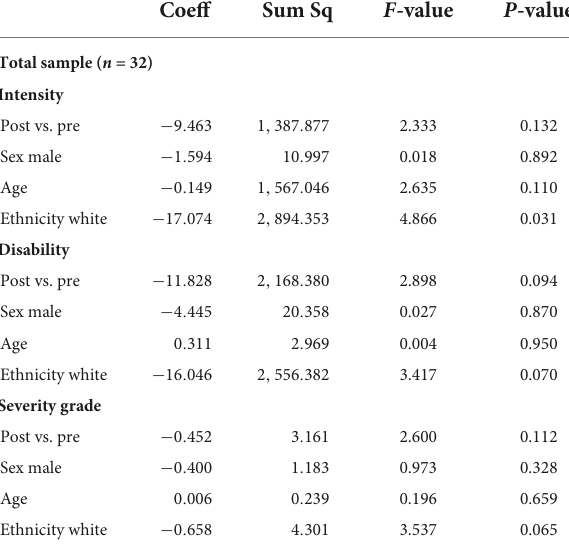
TABLE 7 Multivariable ANOVA, adjusted for demographics (sex male vs. female, age, Ethnicity white vs. non-white) for cluster 1-high ( n = 9).